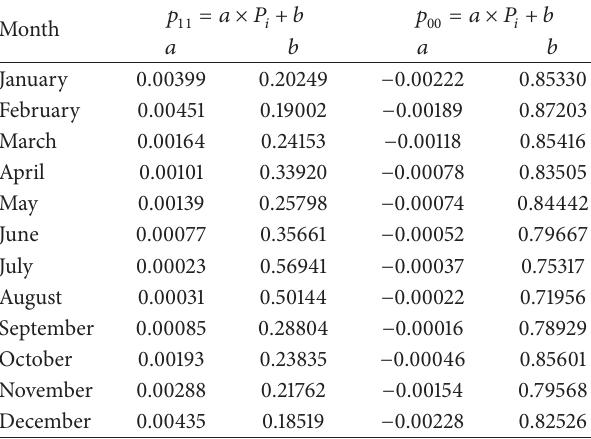
Table 2: Regression curves of transition probabilities ( 𝑝 11 and 𝑝 00 ) estimated with respect to the monthly rainfall amounts ( 𝑃 𝑖